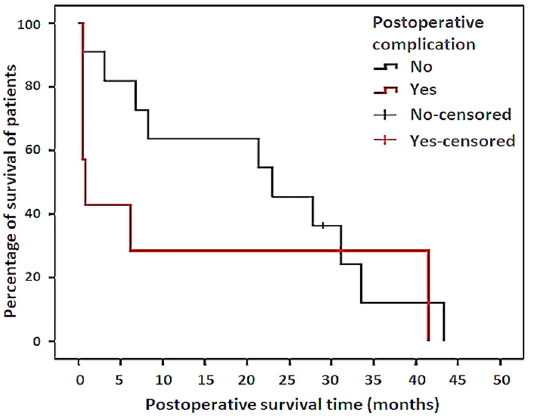
Figure 5. Kaplan–Meier survival curve comparing the cumulative postoperative survival of patients without (No) and with postoperative complications (Yes).